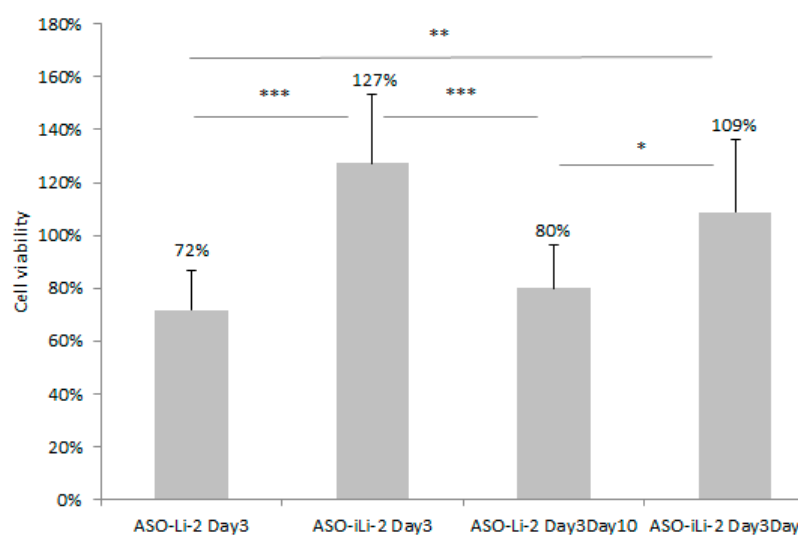
Figure 8. Cell viability (%) of 5000 PC-3 cell spheroids when exposed to ASO-Li-2 at 8 nM and ASO-iLi-2 at 8 nM for 4h at day 3 and days 3–10 (***, 0; **, 0.001; * 0.01).